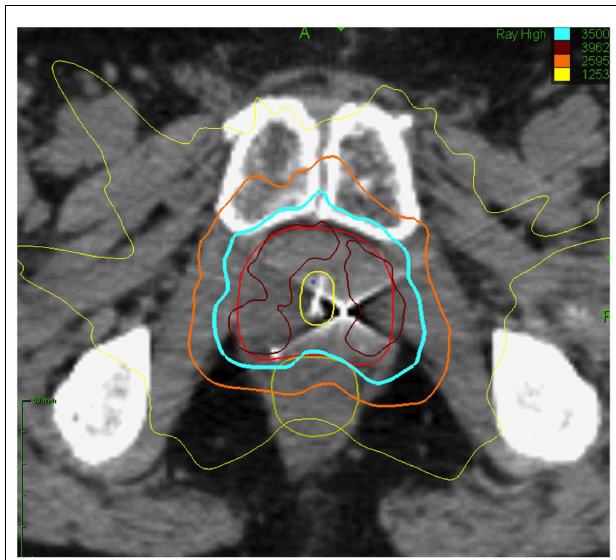
FIGURE 1 | Prostate SBRT: treatment planning axial computed tomography images demonstrating the prostate (red line), prostatic urethra (yellow), and rectum (green line) . Isodose lines shown as follows: 115% of the prescription dose, maroon line; 100% of the prescription dose, light blue line: 75% of the prescription dose, orange line; and 35% of the prescription dose, green line.